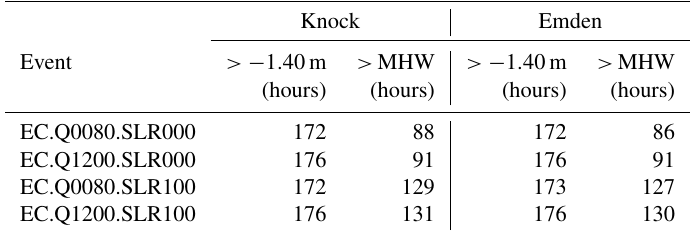
Table 2. Duration of water levels higher than a selected threshold (here NHN − 1.40m) and MHW (at Knock MHW = NHN + 1.39m; at Emden MHW = 1 . 48m) for EC with varying river runoff Q , sea level rise SLR and an operated storm surge barrier. The period investigated covers